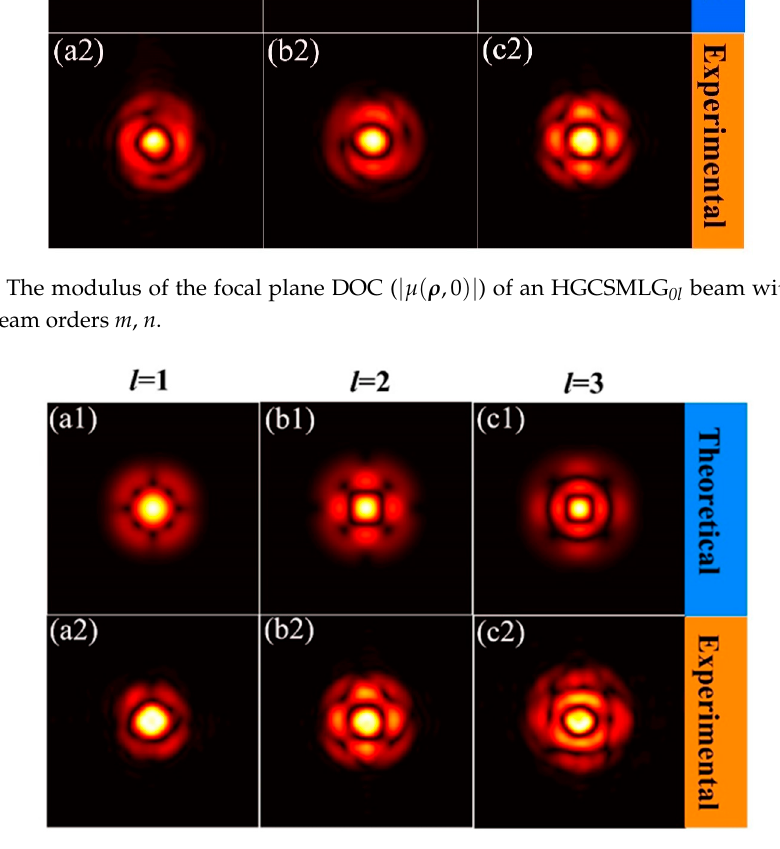
Figure 13. The modulus of the focal plane DOC ( | µ ( ρ ,0 ) | ) of an HGCSMLG 0l beam with m = 1, n = 1 and increasing values of TC.